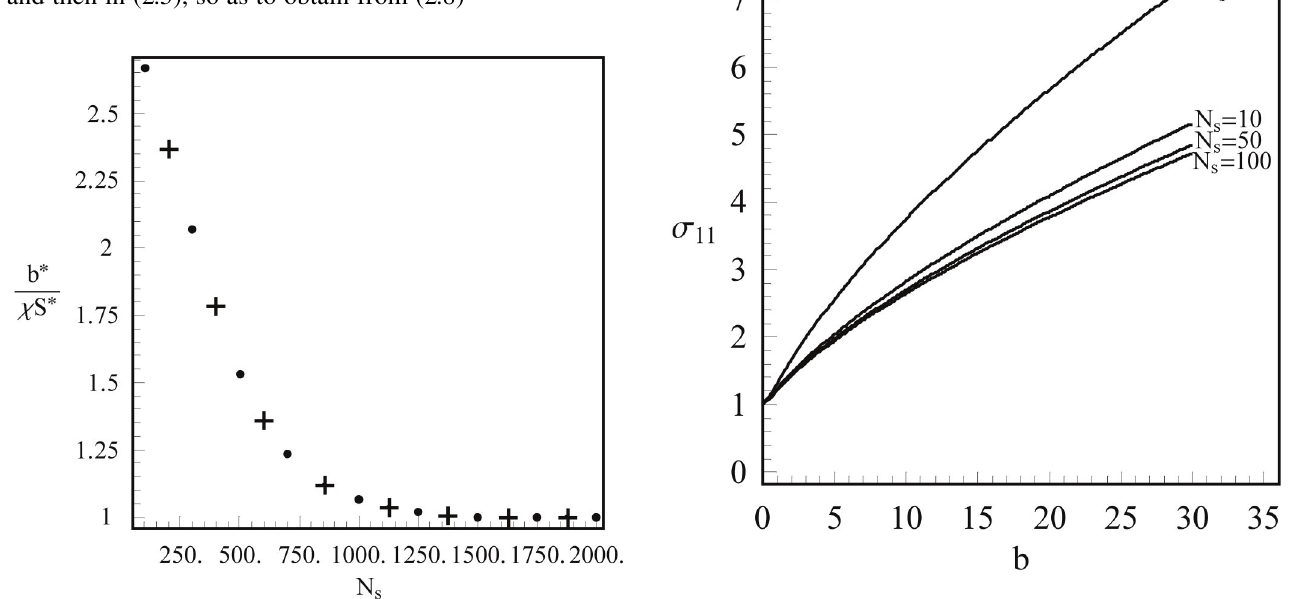
FIG. 4. Gaussian approximation with (cid:3) 0 wake. The ratio b (cid:20) =/S (cid:20) versus N 0 : 2 (crosses).